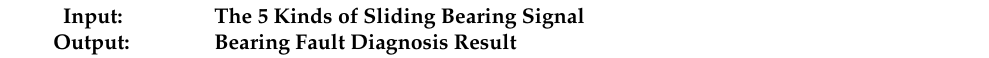
Table 4. Pseudocode of the stepwise intelligent fault